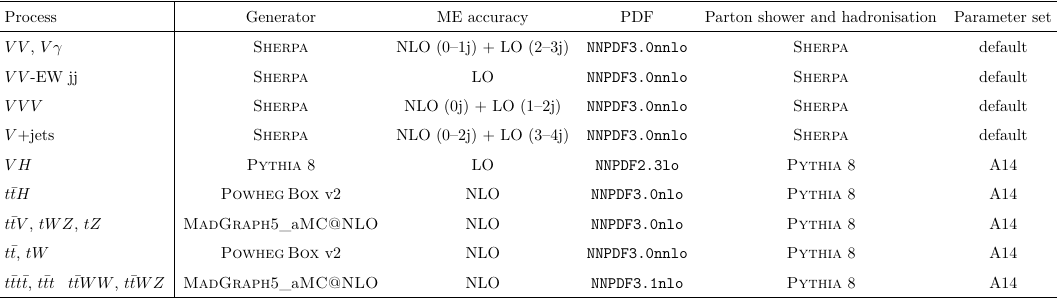
Table 2 . Summary of the event generators, parton shower models, and PDF sets used for the simulation of the background event samples. The notation V is used to refer to an electroweak gauge boson W or Z/γ ∗ . In the final column, ‘default’ refers the to default parameter set provided with the event